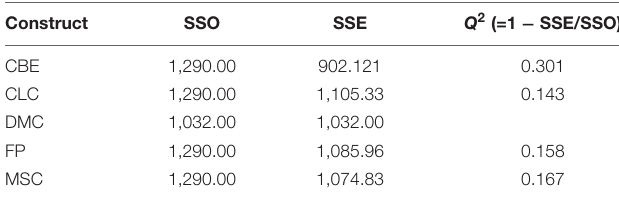
TABLE 5 | Predictive